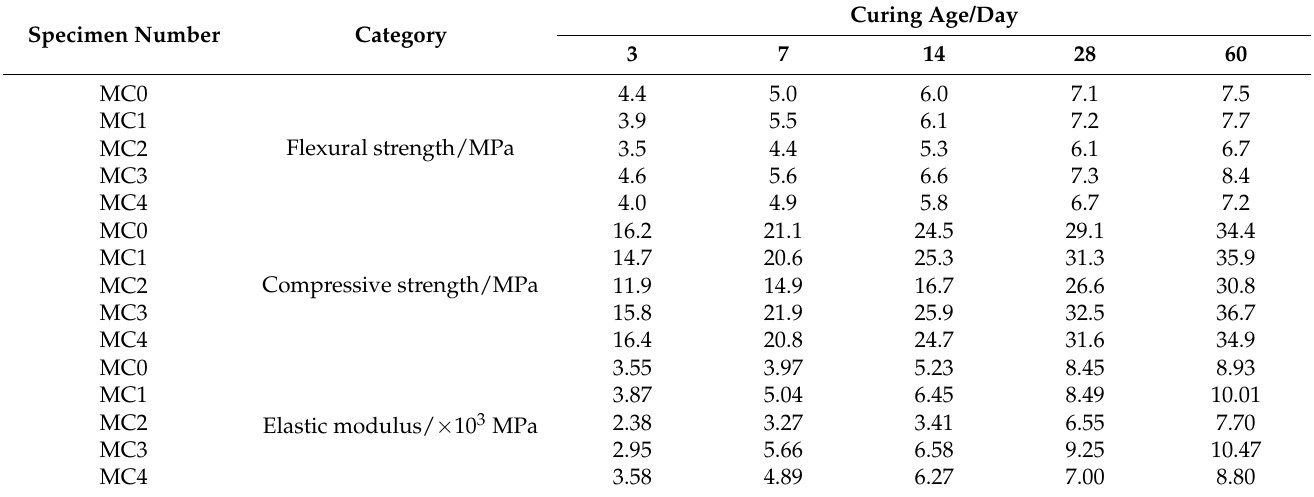
Table 6. Mechanical properties of